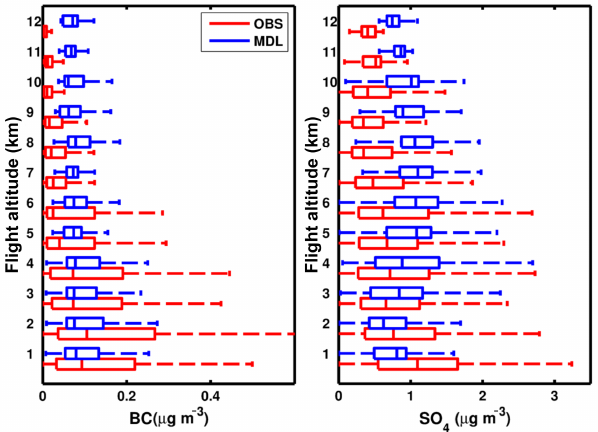
Figure 4. Comparison of model and observation BC and sulfate (SO 4 ) for all ARCTAS flights. In each box-and-whisker plot, the middle line denotes the median value, while the edges of the box represent 25th and 75th percentile values, respectively. The whiskers denote the maximum and minimum